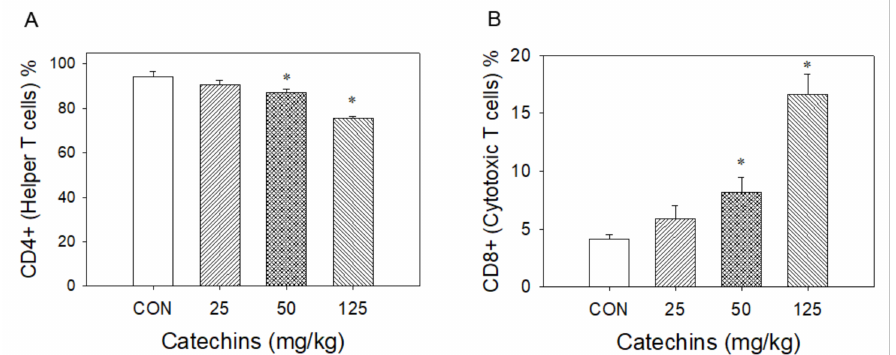
Figure 4. After 4 weeks of catechins ingestion, the percentage change of splenic T lymphocytes in mice. Using flow cytometry assay, catechins treatment significantly and dose-dependently decreased % of splenic CD4 + T lymphocytes ( A ) and increased % of CD8 + T lymphocytes ( B ); * p < 0.05 vs. control (0 mg/kg).